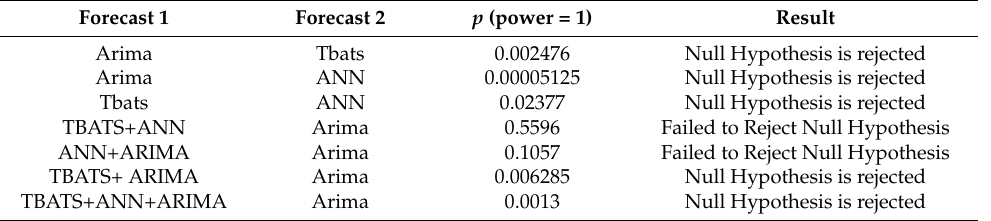
Table 9. Comparing predictive accuracy via the Diebold-Mariano test.